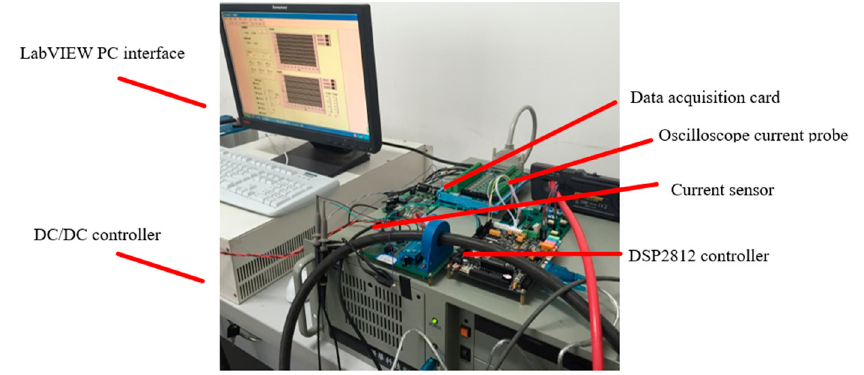
Figure 19. Hardware circuit design and host computer interface.